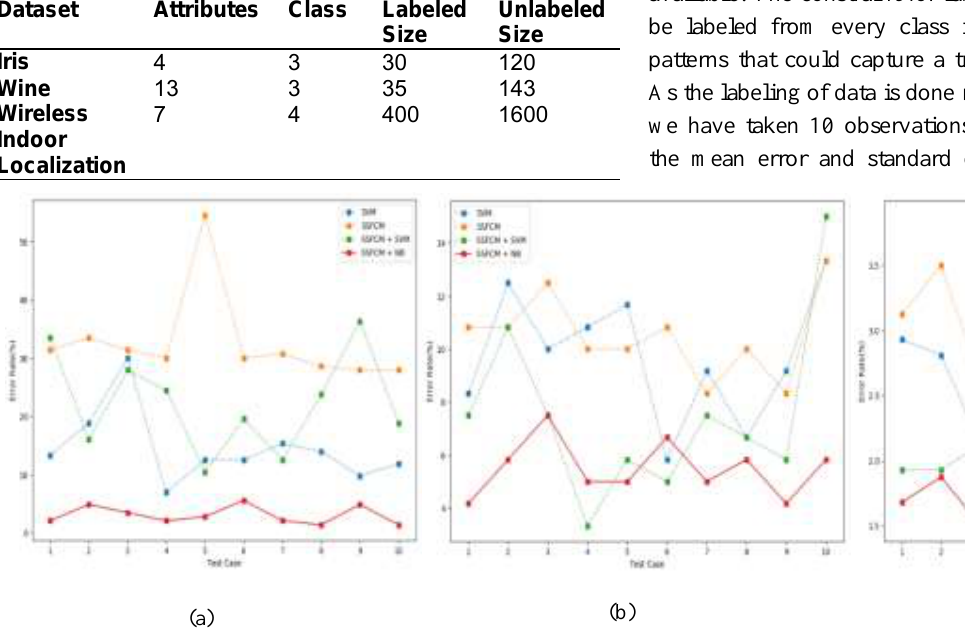
Table 1. Details of real datasets taken from UCI repository